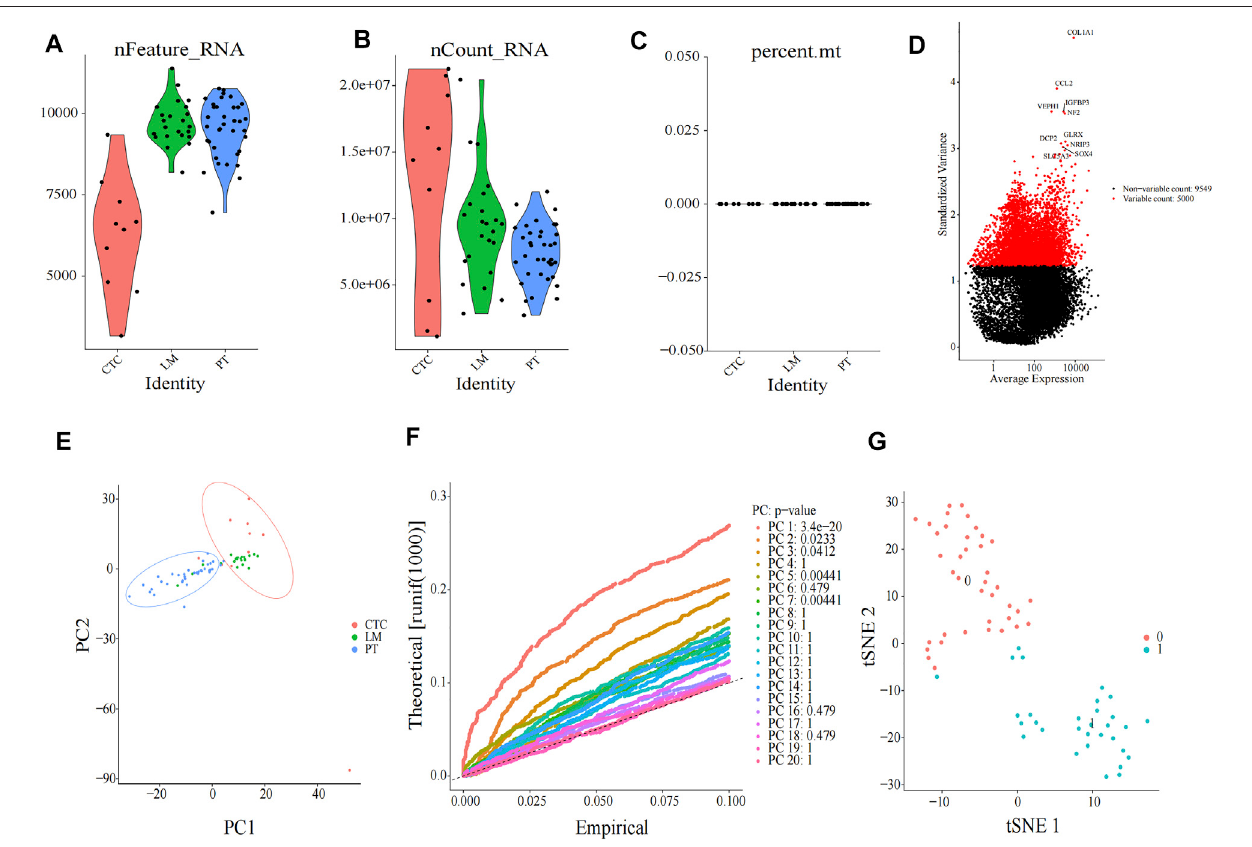
FIGURE5| Clusteringofcellsaftersingle-cellsequencing.Qualitycheckof70single-cellsequencingin (A) nFeature, (B) nCount,and (C) percentmtthreeaspects, as shown in violin plots. (D) Scatter diagram of larger expression alteration in different cells and the top 5,000 were marked red pots. (E) PCA of 70 cells. (F) JackStraw plotofthe fi rst20PCs. (G) t-SNEplotof70cells.Allcellscanbedistributedintotwoclusters(cluster0andcluster1).CTC,circulatingtumorcell;LM,livermetastasis;PT, primary tumor; PCA, principal component analysis; PC, principal components; tSNE, t-Stochastic Neighbor Embedding.